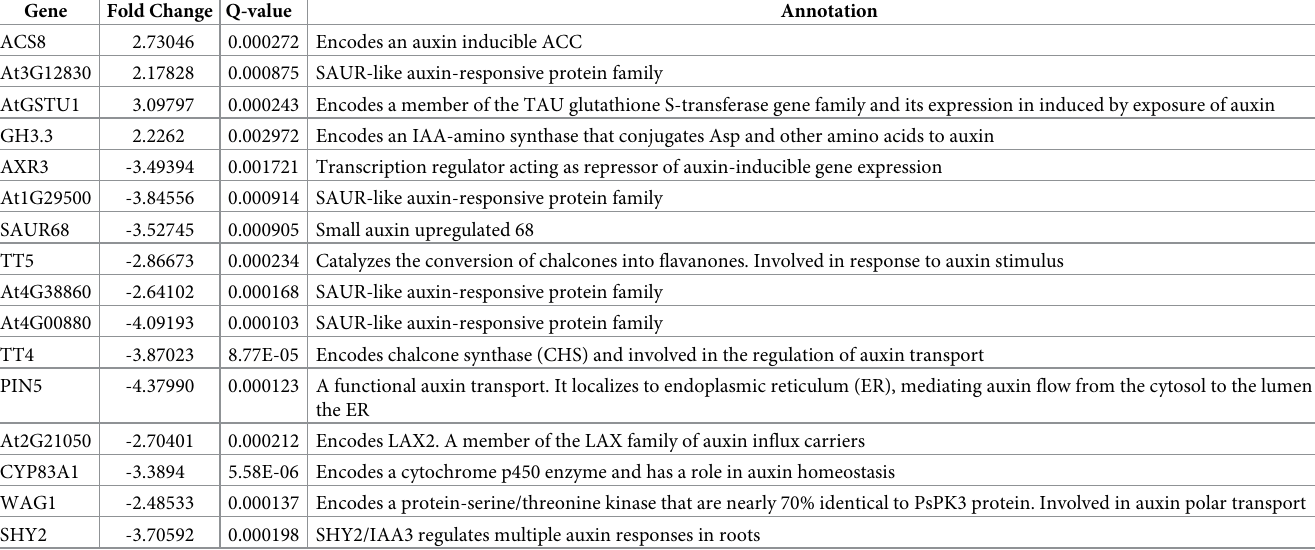
Table 2. Auxin related genes with the expression affected by melatonin treatment by at least 2 fold in RNA-seq